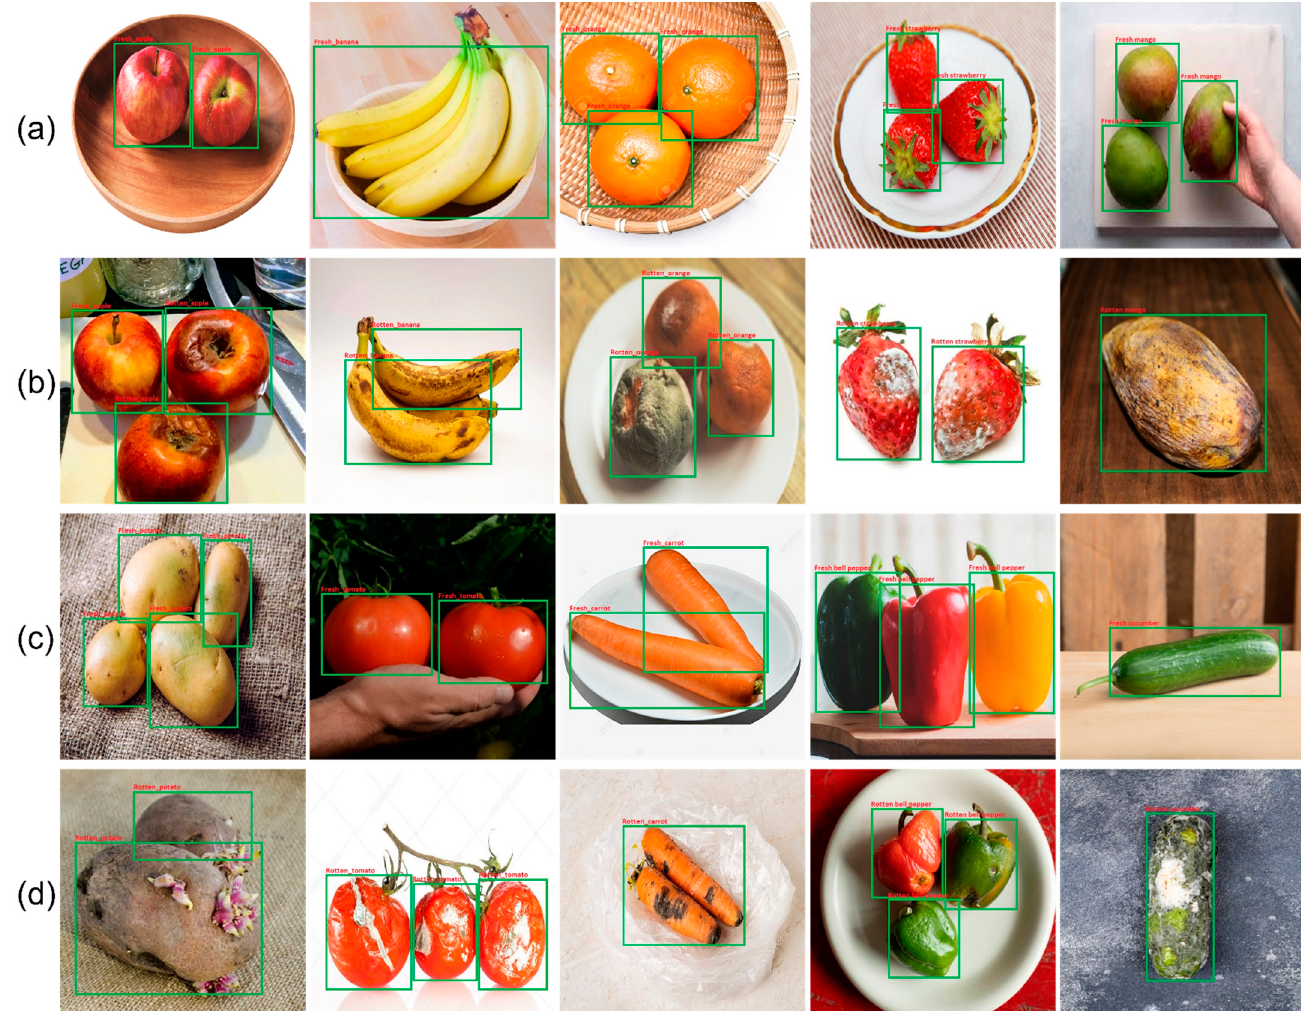
Figure 5. Classification results of the proposed fruit and vegetable model. ( a ) Fresh fruits, ( b ) Rotten fruits, ( c ) Fresh vegetables, ( d ) Rotten vegetables.